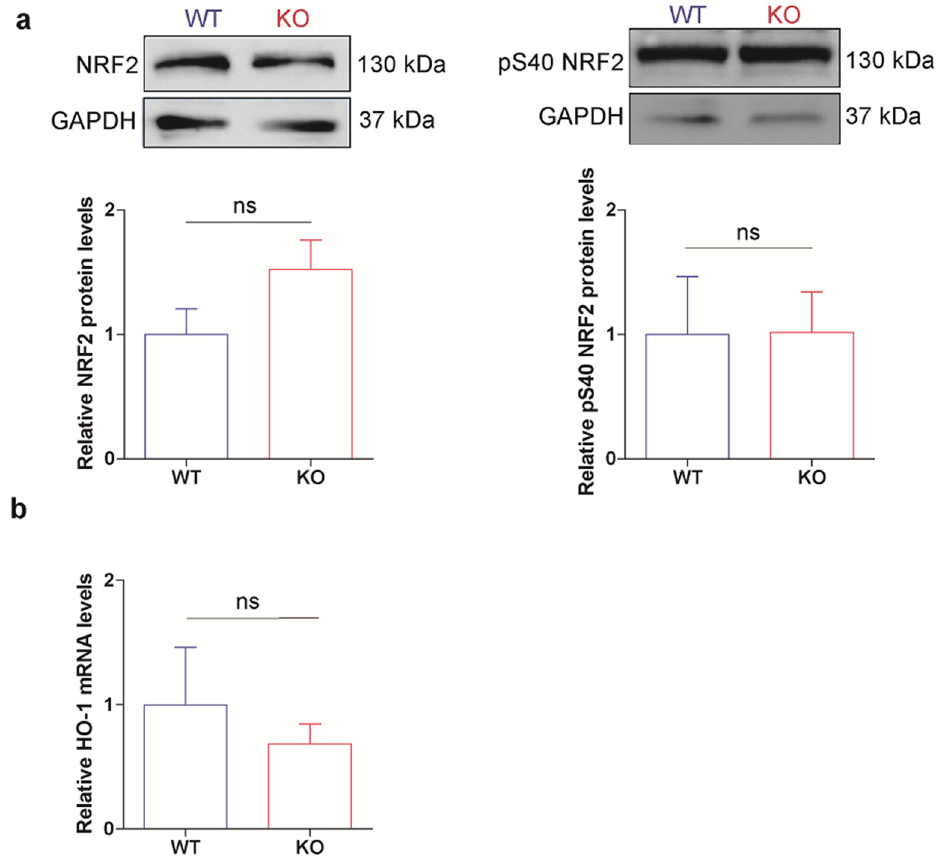
Figure 2. Increased HO-1 expression is not regulated at the transcriptional level. WT and p53 KO ES cells were cultured under standard conditions. ( a ) NRF2 and pS40 NRF2 levels were analyzed by Western blot. Upper panels show representative blots. GAPDH was used as loading control. Lower panels show NRF2 and pS40 NRF2/GAPDH band densitometry relative to WT ES cells. Bars represent the mean ± SEM of three independent experiments. ( b ) HO-1 mRNA levels were analyzed by RT-qPCR, normalized to the housekeeping gene Gapdh and referred to WT ES cells. Bars represent the mean ± SEM of three independent experiments. Non-significant (ns) differences between cell lines were observed.